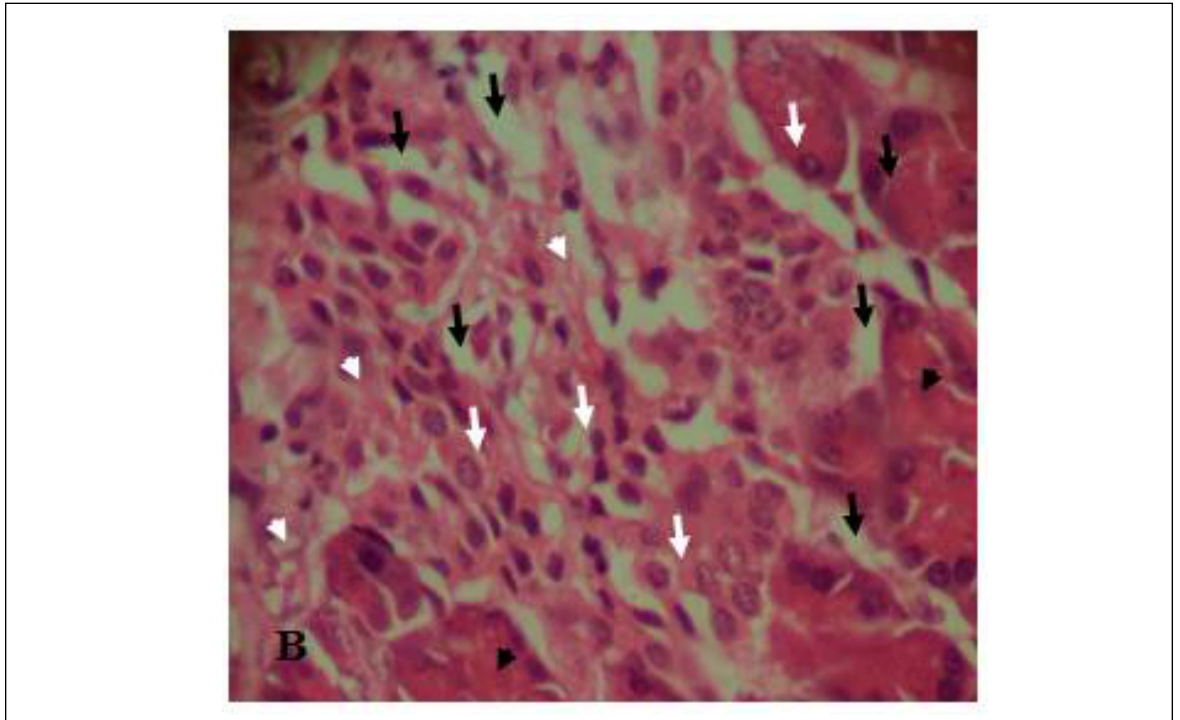
Plate 5 (Group 5): Pancreas of Wistar rat induced with diabetes mellitus and not treated, showing tissue atrophy as evident by the increase in interstitial spaces (black arrows) and necrosis as demonstrate by the degeneration of both nuclear and cytoplasmic components (white arrowheads). Normal cells present with intact secretory acinar (black arrowheads) with their corresponding centroacinar cells. H&E B: